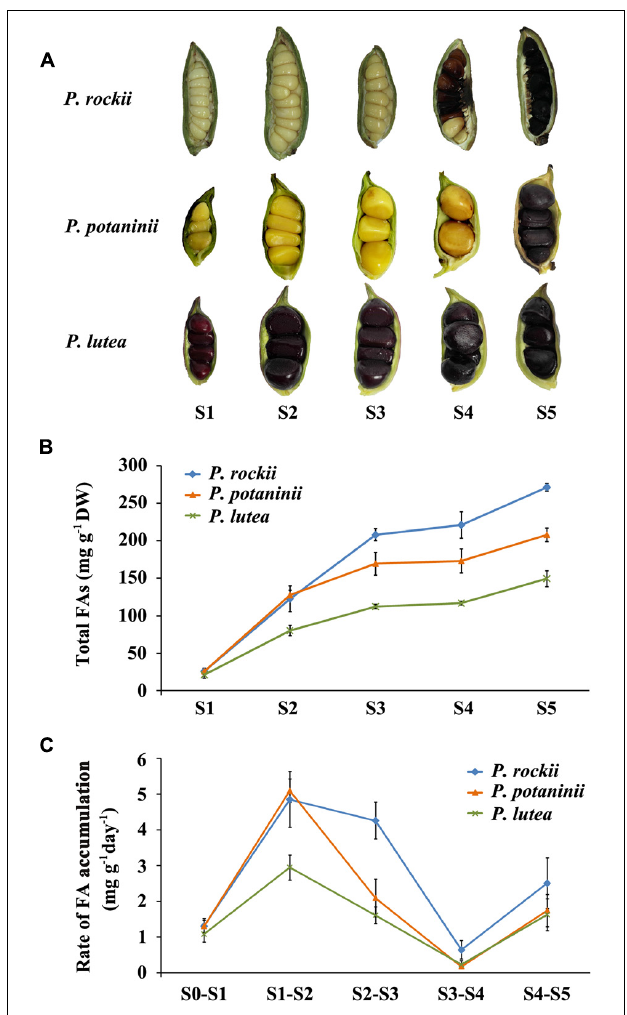
FIGURE 2 | Phenotypic observation and fatty acid quantification of developing seeds of three peony species. (A) The developmental progress of three wild peony species seeds (S1–S5). Pods were harvested at 20 days after pollination (DAP, immature stage), and then every 20 days until 100 DAP (pods containing mature seeds). (B) Total fatty acids content was measured at five developmental stages during seed development of three wild peony species (mean ± SD, n = 3). (C) Rate of FA accumulation between stages was calculated per day (mean ± SD, n =